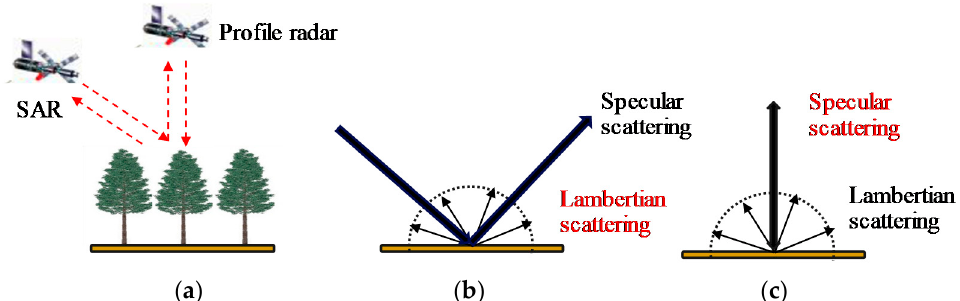
Figure 3. The illustration of the major ground surface scattering type of SAR and profile radar: ( a ) observation direction of SAR and profile radar; ( b ) Lambertian scattering is the major ground surface scattering type in SAR data; ( c ) specular scattering is the major ground surface scattering type in profile radar data.